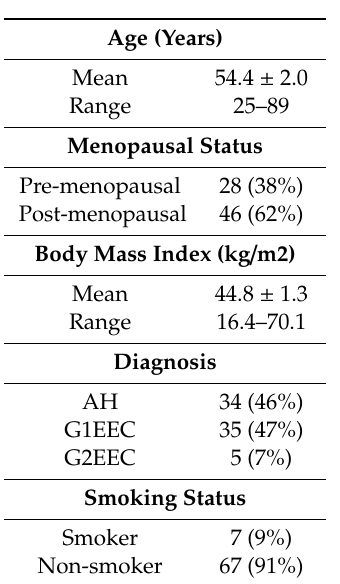
Table 1. Baseline patient characteristics (n = 74).